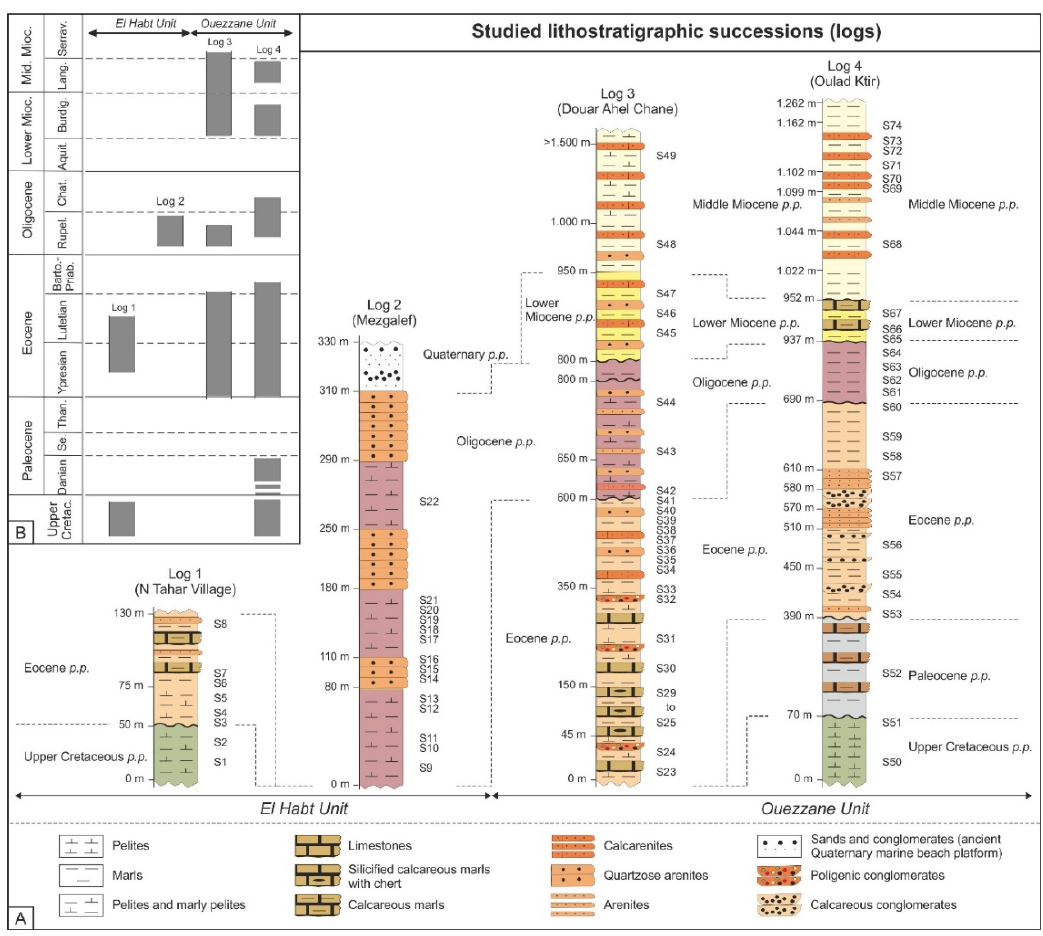
Figure 2. Synthetic litho- and biostratigraphy results of the stratigraphic sections concerning the El Habt and Ouezzane Units. ( A ) lithostratigraphy of the studied successions (located in Figure 1) and lateral correlations with location of the collected samples; ( B ) chronostratigraphic range and synthetic chronology of the studied successions.